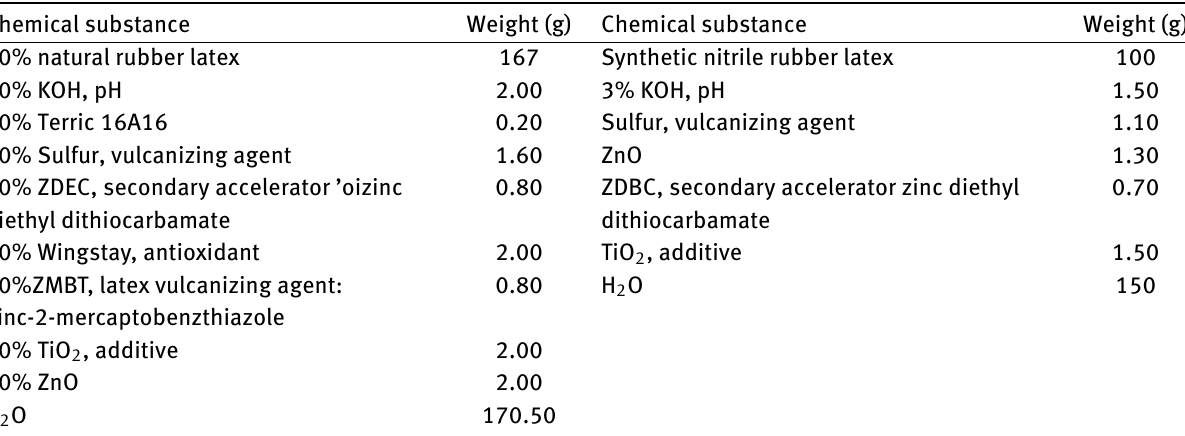
Table 1: Formulas of natural and synthetic rubber latex compounds for preparation glove films Chemical